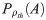
Temporal analysis of vegetation patterns.Panel A shows the survey area, the Sahel region in Africa (taken from Sentinel-2 cloudless— https://s2maps.eu by EOX IT Services GmbH (Contains modified Copernicus Sentinel data 2016 and 2017)), together with (average) rainfall lines (taken from [26]). In panel B the local response curve, i.e., the normalized differences between the years 1999 and 2002 ((αρ2002 − ρ1999)/ρ1999, where ρ is the local vegetation density and the constant α was chosen such that the average growth is zero), is plotted against ρ1999 for all pixels between rainfall lines 400-700 mm/y (main plot) and for other precipitation regions (inset), showing what appears to be purely negative feedback (see Text C in S1 Appendix for details and errorbars). A spatial cluster is defined as a connected collection of elementary 30m squares all, above some threshold vegetation density ρth (see Methods). The chance of a cluster of a given spatial area A, Pρth(A), to grow between the years ’99 and ’02, normalized by the chance of growth of an elementary cluster, Pρth(1)), is plotted in panel C. Its increase with the size of the cluster, predicted in [16], appear to support the positive feedback hypothesis. Different lines correspond to different threshold density ρth used to define a “cluster”, making it clear that the positive response of small clusters is independent of this definition.